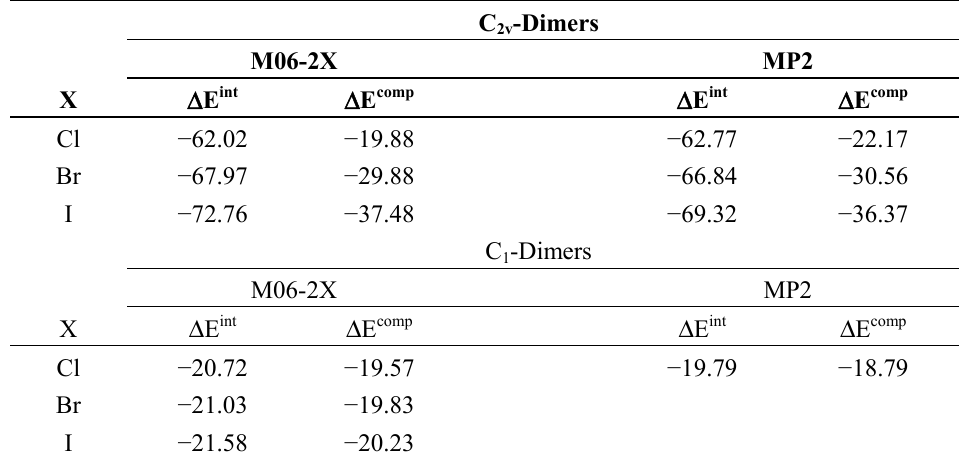
Table 4. Interaction energies, Δ E int , and complexation energies, Δ E comp , using the aug-cc- pVTZ basis set. Values in kcal/mol